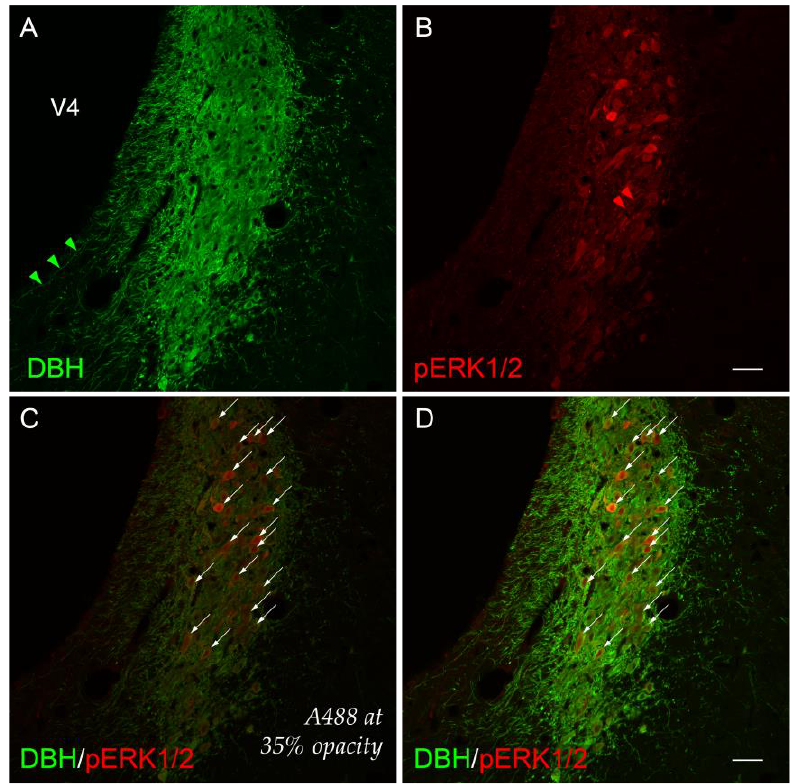
Figure 3. A higher-magnification view (cf. Figure 2) of cellular activation observed in the locus ceruleus (Wenzel and Wenzel, 1812) (LC) [82] 15 min after 2-DG administration. Subject K10-027. ( A ) LC perikaryon profiles labeled for dopamine β -hydroxylase (DBH, green ) and ( B ) phospho-ERK1/2 (pERK1/2, red ) appear to co-label the same perikaryon profiles (( D ), arrows ). ( C ) Co-labeled perikaryon profiles in the LC (identically marked by arrows as in ( D )) with the A488 ( green ) channel set at 35% opacity renders visible the subtle, graded activation profiles of phospho-ERK1/2 + signal. Arrowheads ( green in ( A ); red in ( B )) mark single-labeled neurites immunoreactive for DBH or pERK1/2, respectively. Scale bars in ( B , D ) mark 50 µ m and apply to all